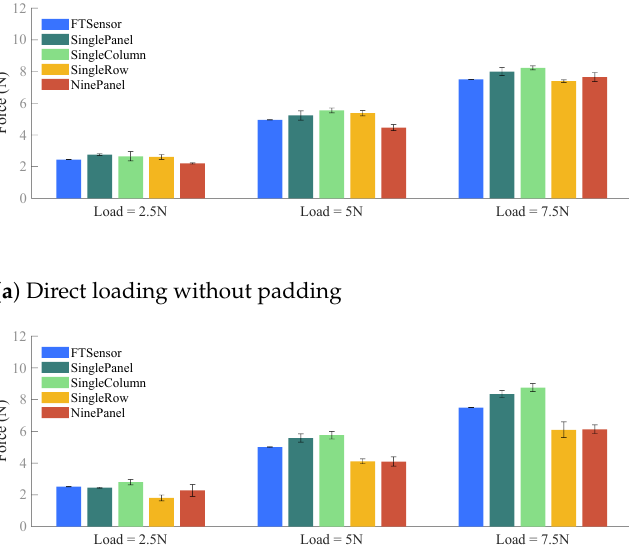
Figure 9. Results comparing the vertical loads measured by the force/torque sensor against the total sum of loads measured by the FSRs (in the vertical direction) for four loading cases: Single Panel, Single Column, Single Row, and Nine Panel, at three load levels. The error bars represent standard error across three repetitions. The error bars represent standard error.